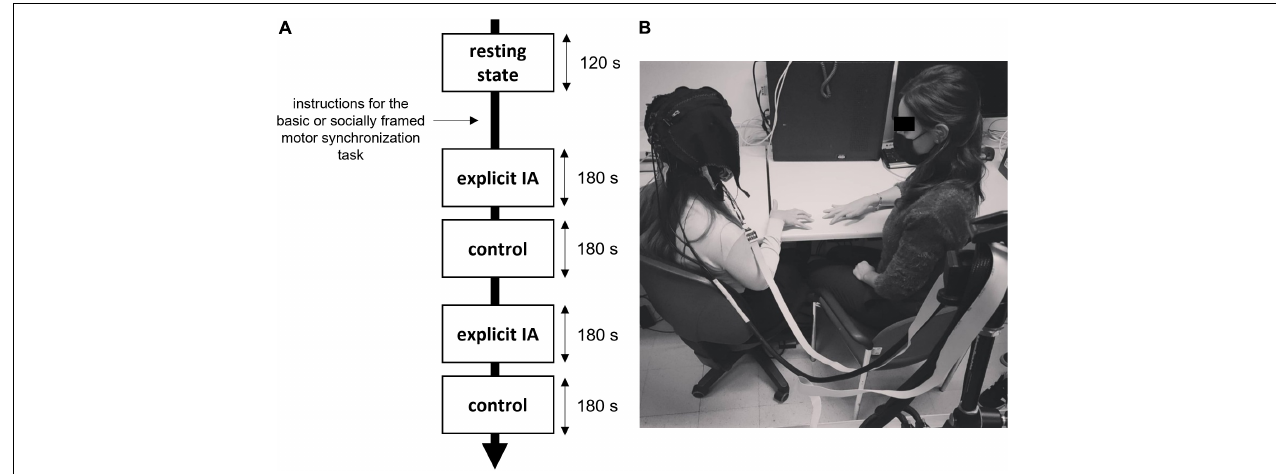
FIGURE 1 | (A,B) Experiment setting and procedure. (A) Duration and timing of the motor tasks requiring synchronization, the instructions were provided both for the explicit IA and control conditions and for the type of the motor task (socially framed or not). (B) An example of an experimental setup with a fNIRS recording device and the experimenter performing the motor